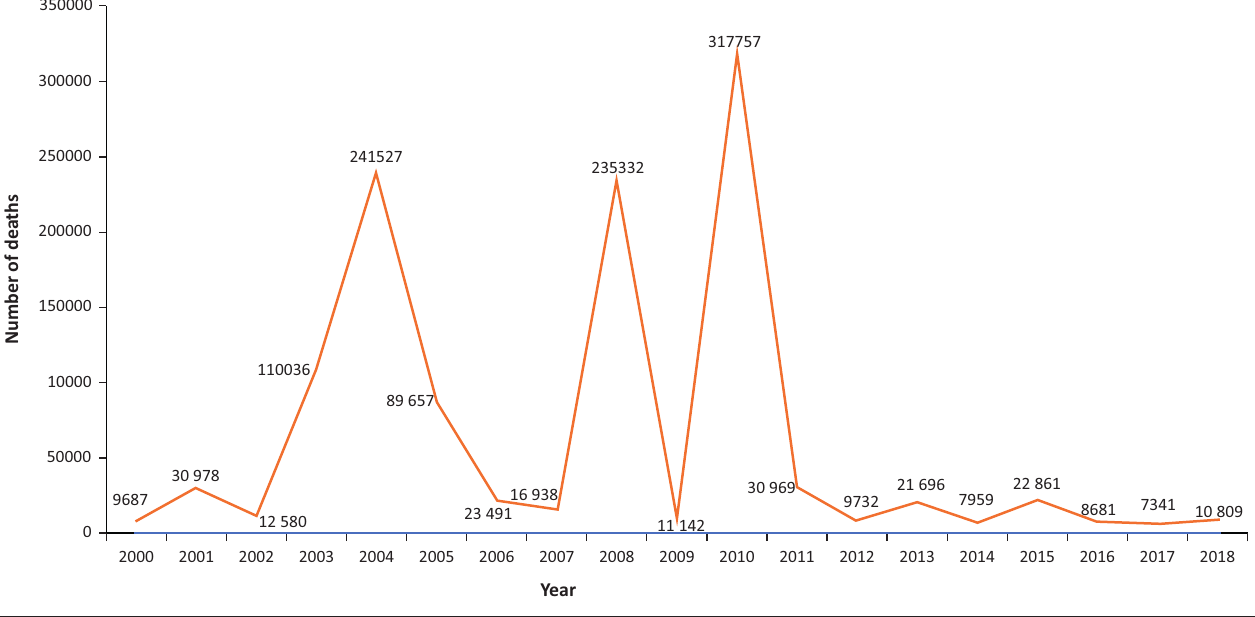
FIGURE 1: Global deaths from natural